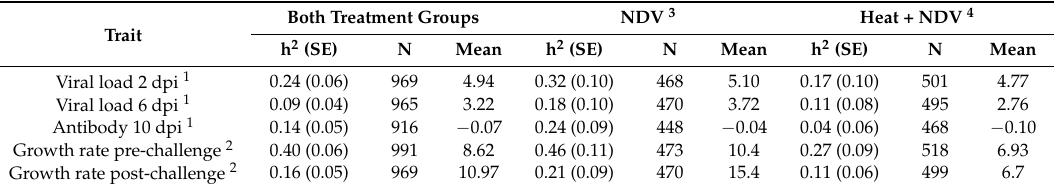
Table 2. Heritability (h 2 ) and descriptive statistics of phenotypes measured in both of the treatment groups and separately in response to NDV (Newcastle disease virus).